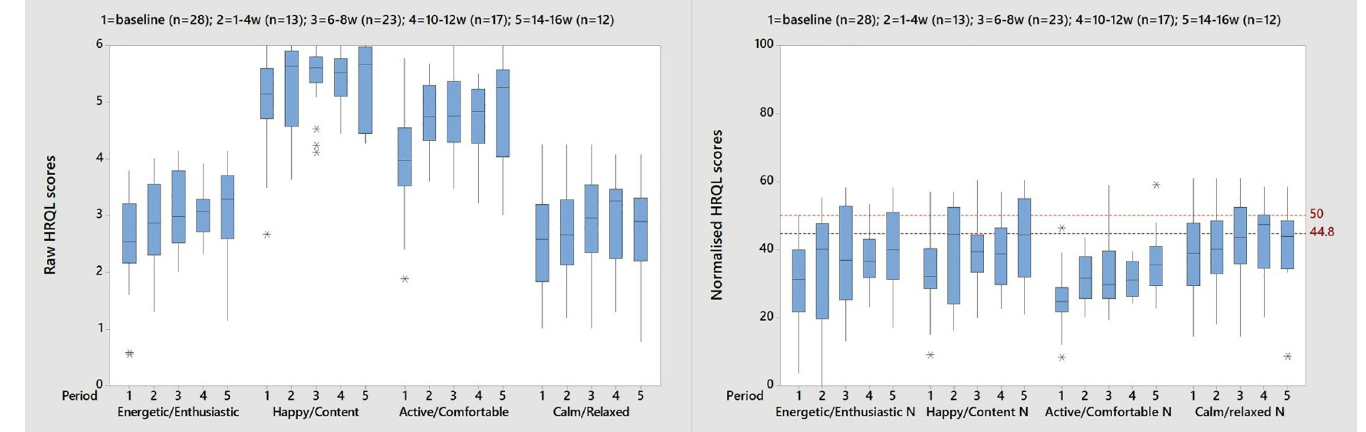
Fig 3. A comparison of raw scores and normalised scores from a study of dogs with osteoarthritis and associated soft issue pathologies treated with regenerative medicine. Raw HRQL scores (left) and Normalised HRQL scores (right). 50 represents the score for the average healthy dog and 44.8 is the threshold above which 70% of healthy dogs will